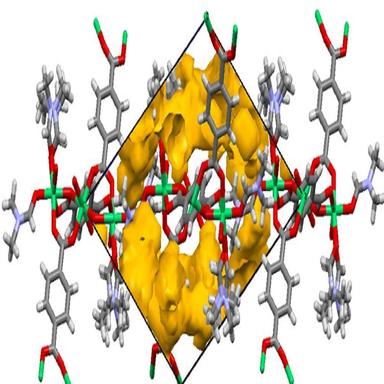
The voids illustrated as volume of channels in the unit cell.